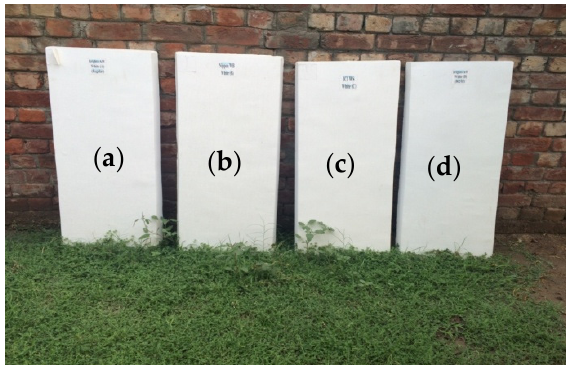
Figure 1. Painted slabs with ( a ) conventional Paint A, ( b ) conventional Paint B, ( c ) conventional Paint C, ( d ) newly developed paint.